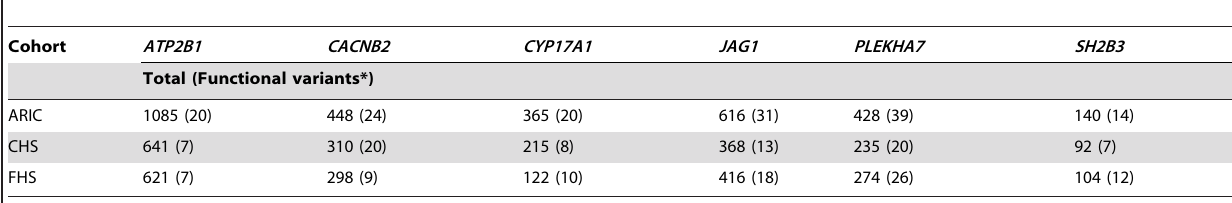
Table 3. Observed rare variants across cohorts.